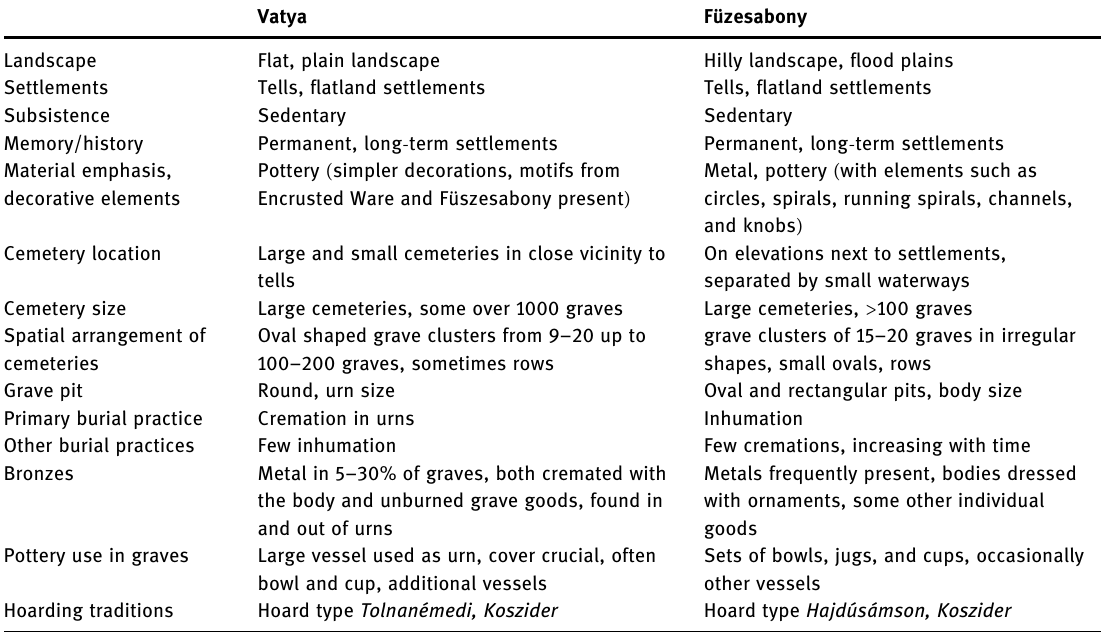
Table 1: Characteristics of Vatya and Füzesabony after Fischl et al. ( 2013 ) and Stig Sørensen & Rebay - Salisbury ( 2008